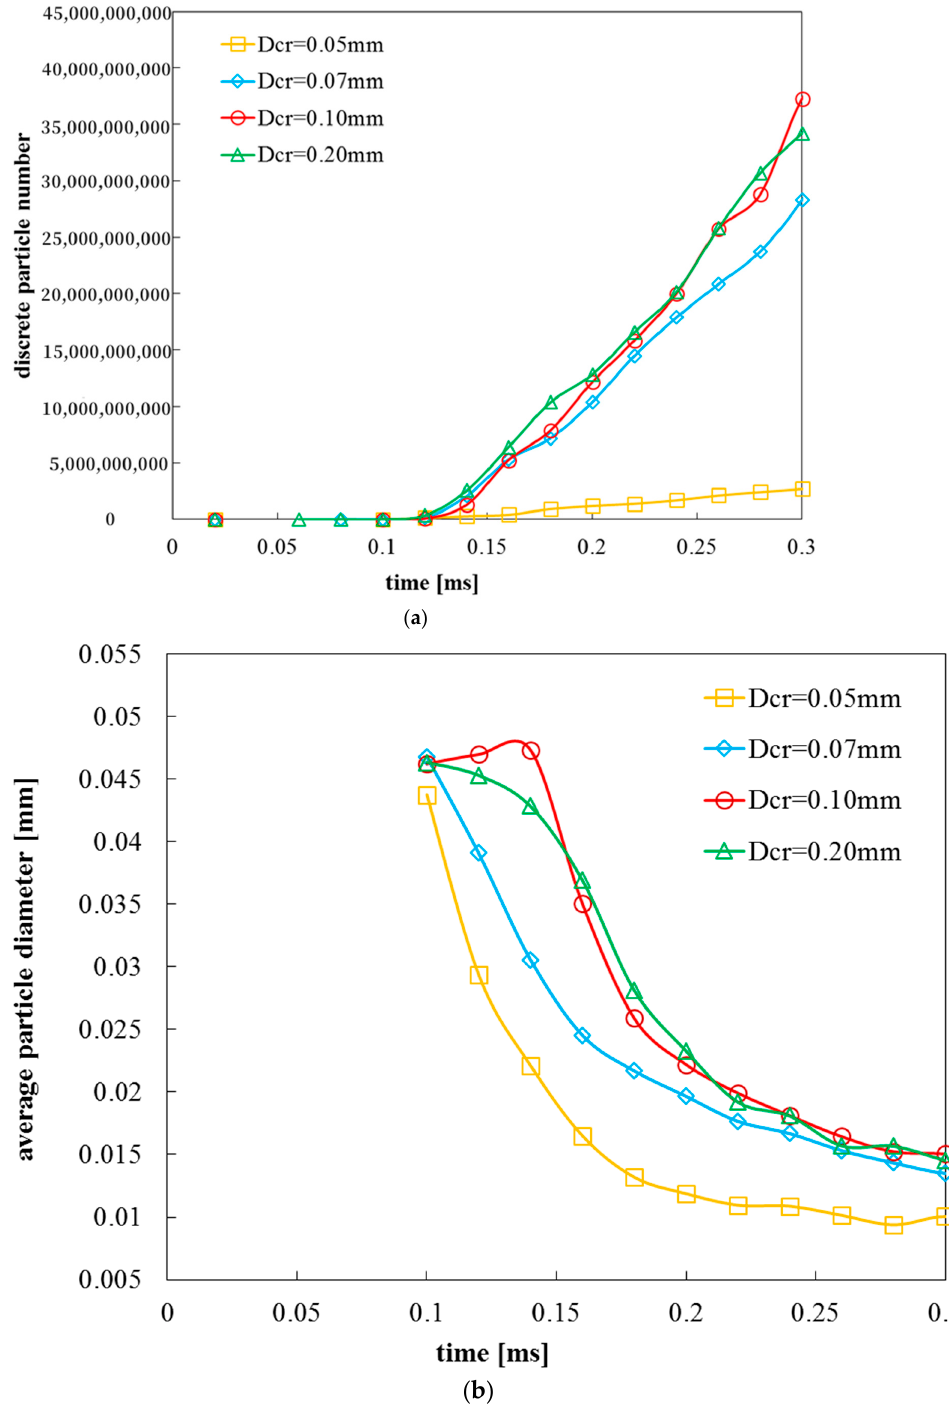
Figure 15. Discrete particles. ( a ) discrete particle number; ( b ) average particle diameter.